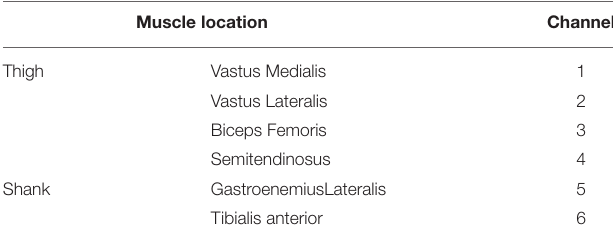
TABLE 3 | Corresponding channels of the sEMG sensor and